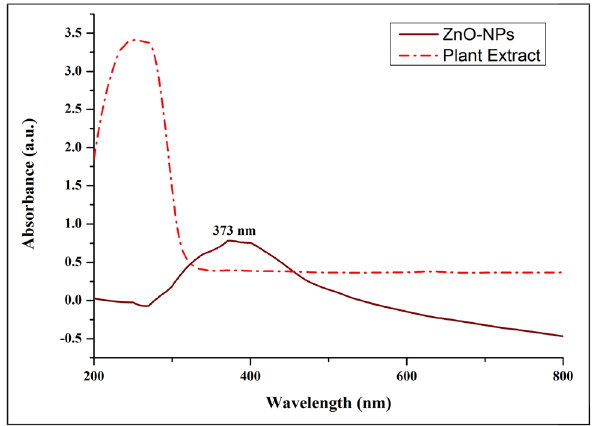
Figure 1: UV - Vis spectroscopic analysis of phyto - fabricated ZnO from S. acuta